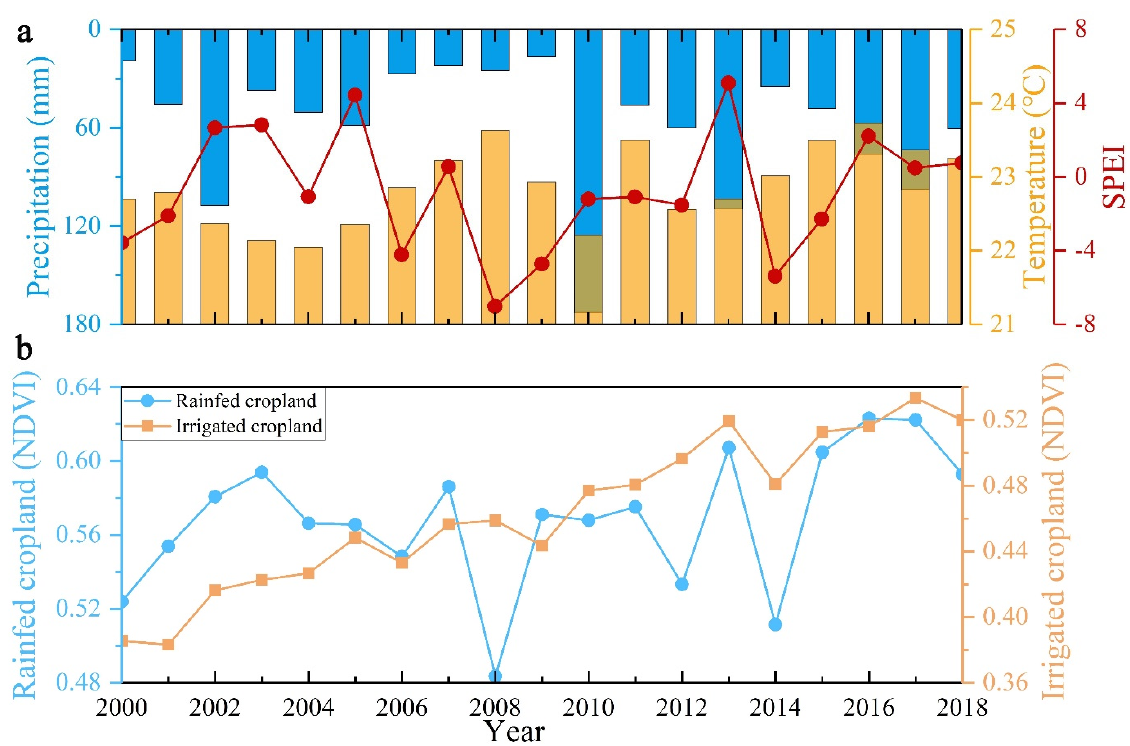
Figure 9. Long-term growing season (May-September) trend of ( a ) total precipitation, and average mean temperature and SPEI that spatially aggregated over cropland, ( b ) the average NDVI mean of the grid cells for rain-fed and irrigated cropland.